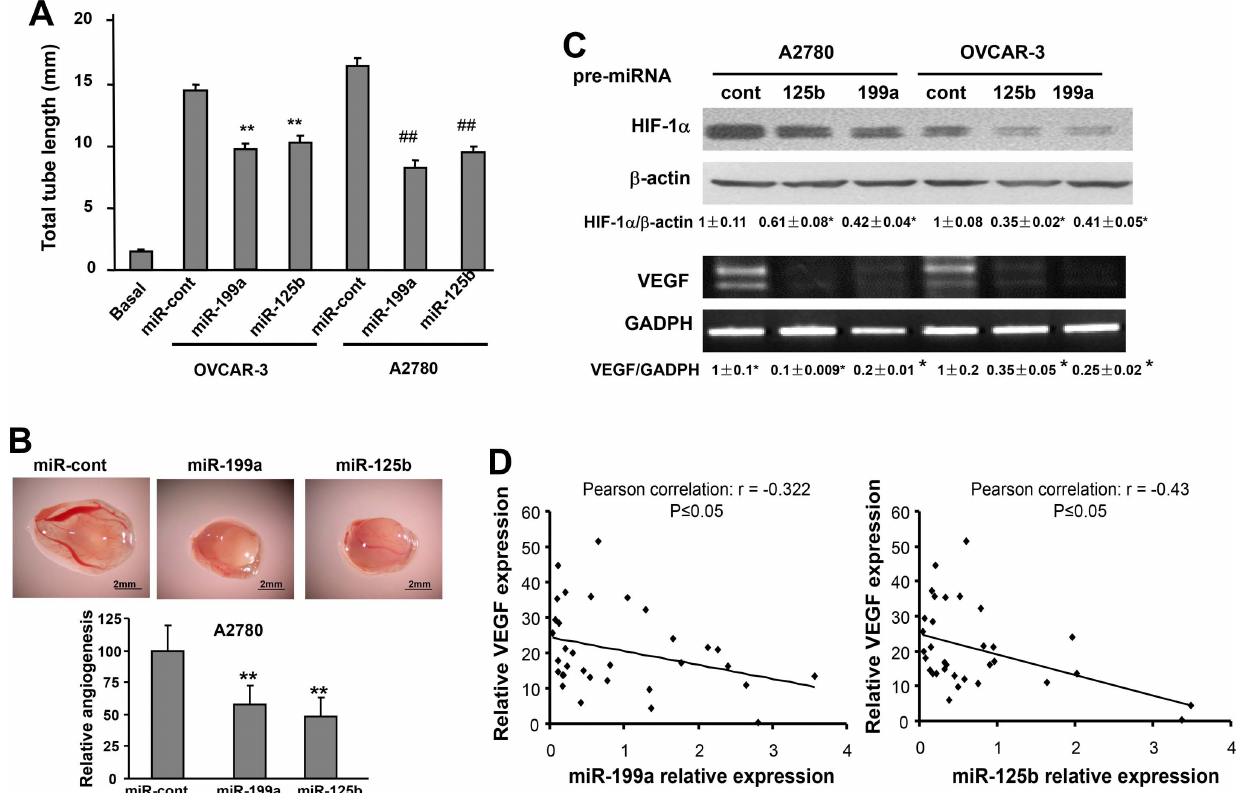
Figure 2. MiR-199a and miR-125b suppress tumor angiogenesis associated with reduction of HIF-1 a and VEGF expression. (A) HUVEC cells were cultured in serum free medium overnight and re-suspended in basic EBM-2 medium. To perform the tube formation assay, HUVEC cells were incubated in basic EBM-2 medium; conditioned medium prepared from OVCAR-3 or A2780 transfected with pre-miR-control, pre-miR-125b and pre-miR-199a, respectively. Tube formation was determined under light microscope in 12 h. Total tube length (mm) was presented as mean 6 SE from six replicates for each treatment. **Significantly different compared with OVCAR-3 control (P , 0.01). ## Significantly different compared with A2780 control (P , 0.01). (B) A2780 cells were transfected with 30 nM pre-miR-125b, pre-miR-199a and pre-miR-control precursor, respectively. After transfection (24 h), 2 6 10 6 cells were trypsinized, suspended, and mixed with equal volume of Matrigel, and implanted onto the chicken CAMs of 10- day-old chicken embryos. The branches of blood vessels were counted as the index of angiogenesis was obtained from the CAMs of 8–10 embryos per treatment 96 h after implantation. The data represent as mean 6 SE of blood vessel numbers, which were normalized to that of the control. **Significantly different compared with that of the control (P , 0.05). (C) A2780 cells and OVCAR-3 cells were cultured under normoxic condition, and transiently transfected as above to analyze HIF-1 a and b -actin protein expression by immunoblotting and VEGF mRNA levels (VEGF-165 and VEGF- 121 isoforms) by RT-PCR. Quantification was performed by scanning densitometry. The results are obtained from triplicate experiments and presented as mean 6 SE. *Significantly difference compared with the same cell lines transfected with miR-cont. (D) VEGF mRNA levels in human ovarian cancer tissues (n=33) were analyzed by SYBR Green qRT-PCR. The Pearson correlations were analyzed between miR-125b or miR-199a expression and its corresponding VEGF expression in cancer tissues.